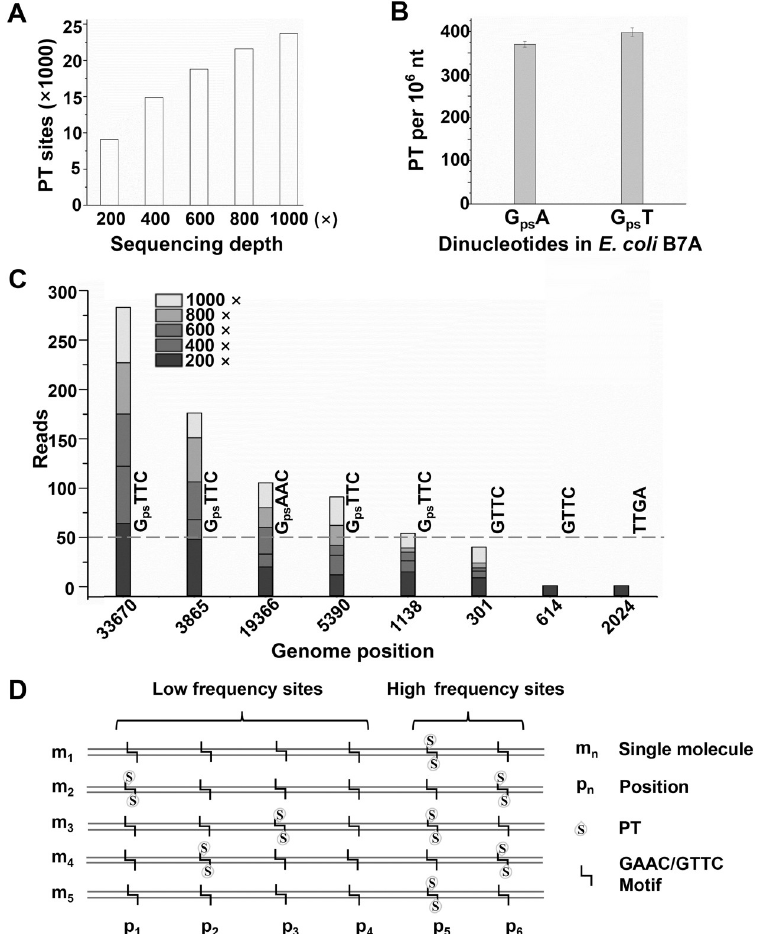
Fig 1. Discovery of new PT sites using deep resequencing and the inconsistency between extensive PT modified sites and the PT linked dinucleotides abundance of the E . coli B7A genome. (A) Plotted PT modified sites detected with the increase of sequencing depth. (B) The PT abundances quantified by LC-MS/MS. Error bars are calculated as the s. d. of three biological replicates. (C) Accumulation of sequencing depth contributed to the revealing of more PT- modified sites. Here, one loci are chosen for each case as an example to illustrate each situation: some sites like loci 33670, the ended reads number of which reached 50 at 200 × was detected as PT modified sites, while some sites like 3865 loci only be regarded as PT modified site when the sequencing depth increase up to 400 × . In other word, if the sequencing depth is only 200 × , they would be identified as non-PT modified sites. Similar phenome can be seen at the sites like 19366 loci (600 × ), 5390 loci (800 × ) and 1138 loci (1000 × ). Also, some sites like 301 loci, the ended reads number of which could not reach 50 even the sequencing depth increased up to 1000 × . While, some GAAC/GTTC sites like 614 loci and some randomly selected non GAAC/GTTC sites like 2024 loci, the ended reads number could not be detected at each five gradient sequence depth. (D) The schematic molecular PT modification. The specific GAAC/GTTC site is partially modified and with different modification frequency. High frequency sites are easy to detected and low frequency sites need further sequencing depth.